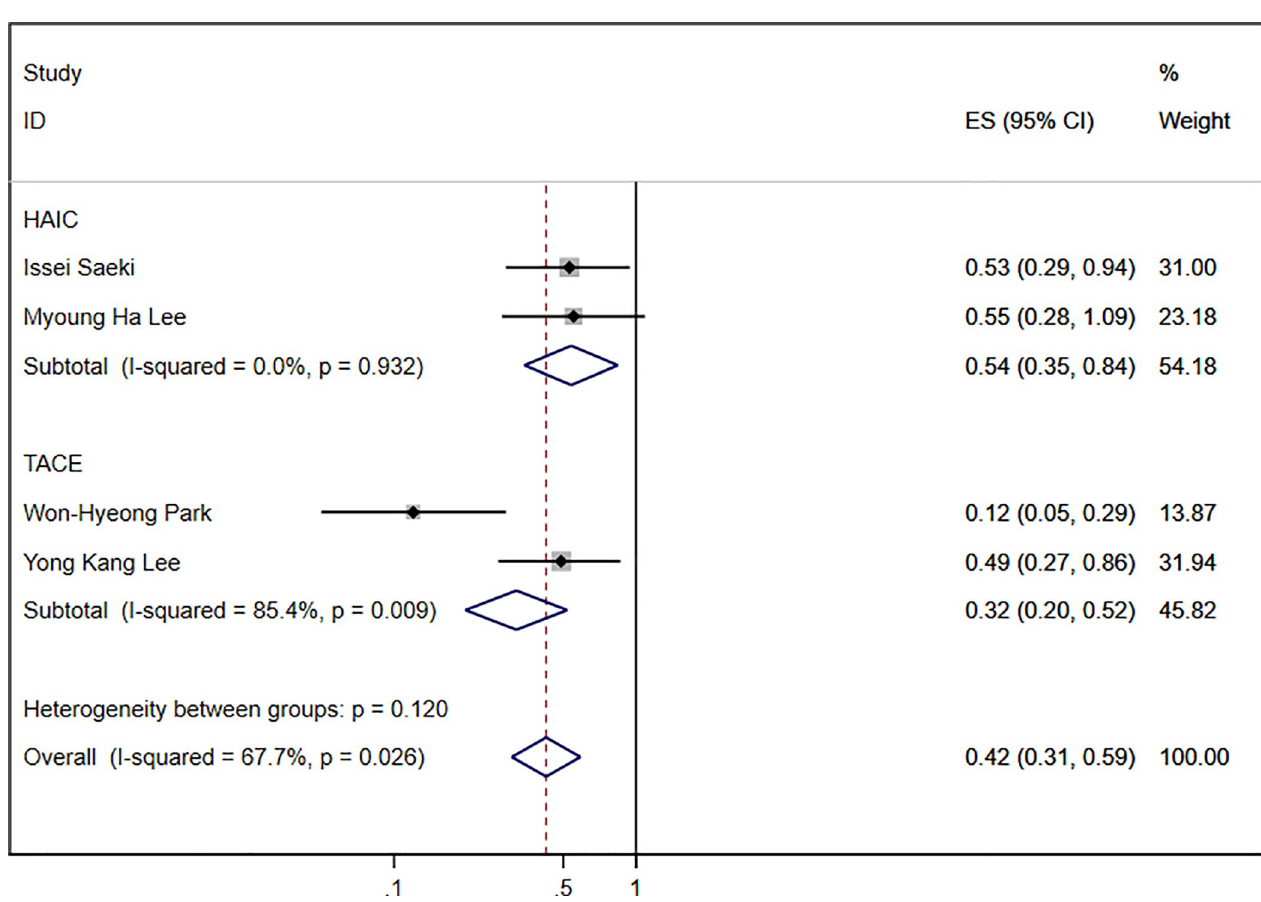
Fig 5. Subgroup analyses of four studies with HR of DCP response for